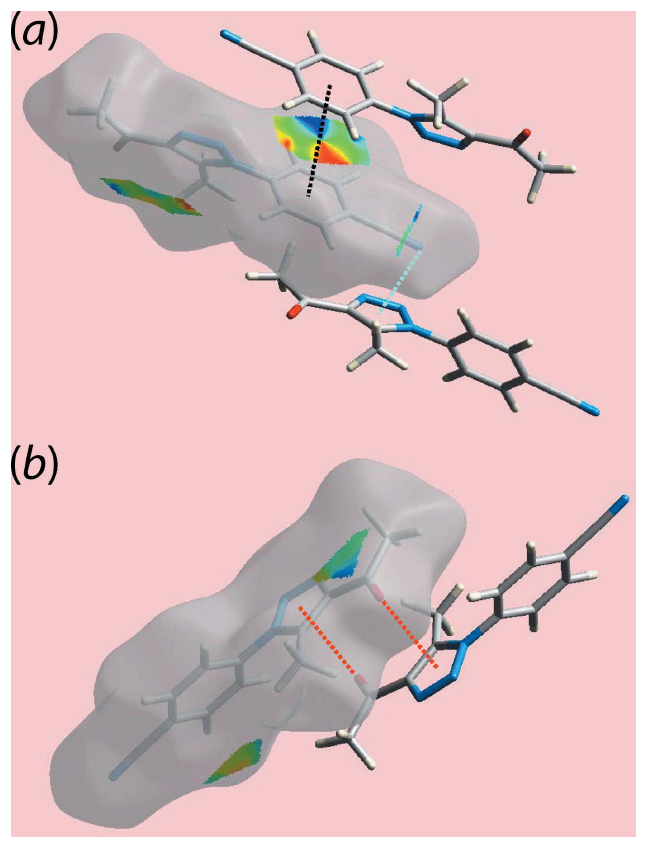
Figure 5 Views of the Hirshfeld surface mapped the shape-index property showing ( a ) (cid:2) – (cid:2) and C N (cid:3)(cid:3)(cid:3) (cid:2) interactions with black and sky-blue dotted lines, respectively and ( b ) C O (cid:3)(cid:3)(cid:3) (cid:2) contacts with red-dotted lines.